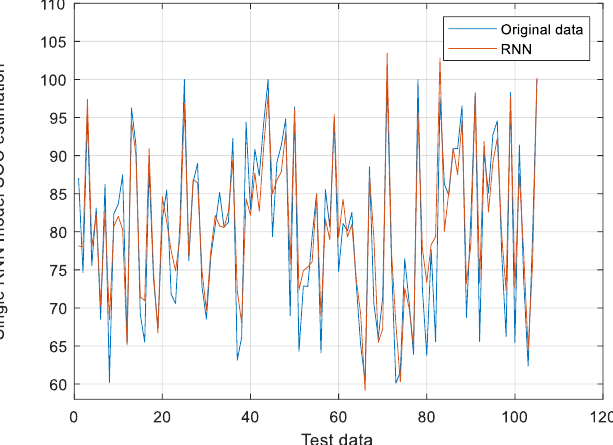
Figure 9. Single RNN model SOC estimation comparison chart.